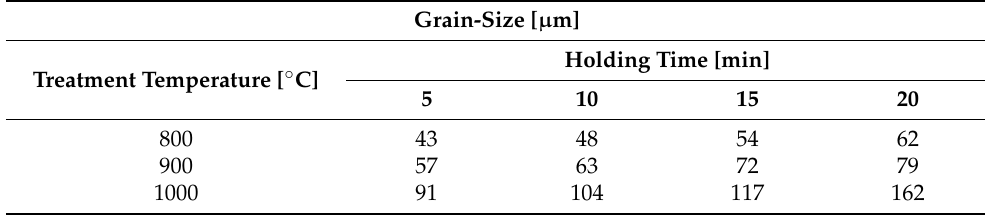
Table 4. Grain-size distribution during solution treatment of TNTZ